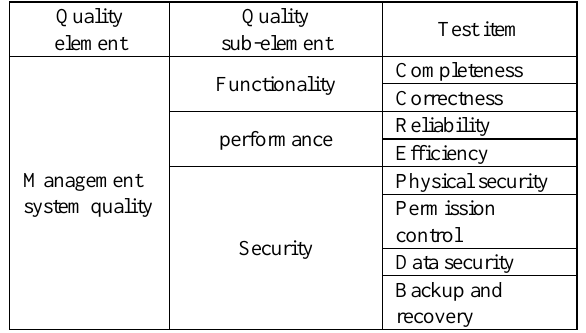
Table 2. List of quality elements, quality sub-elements and test